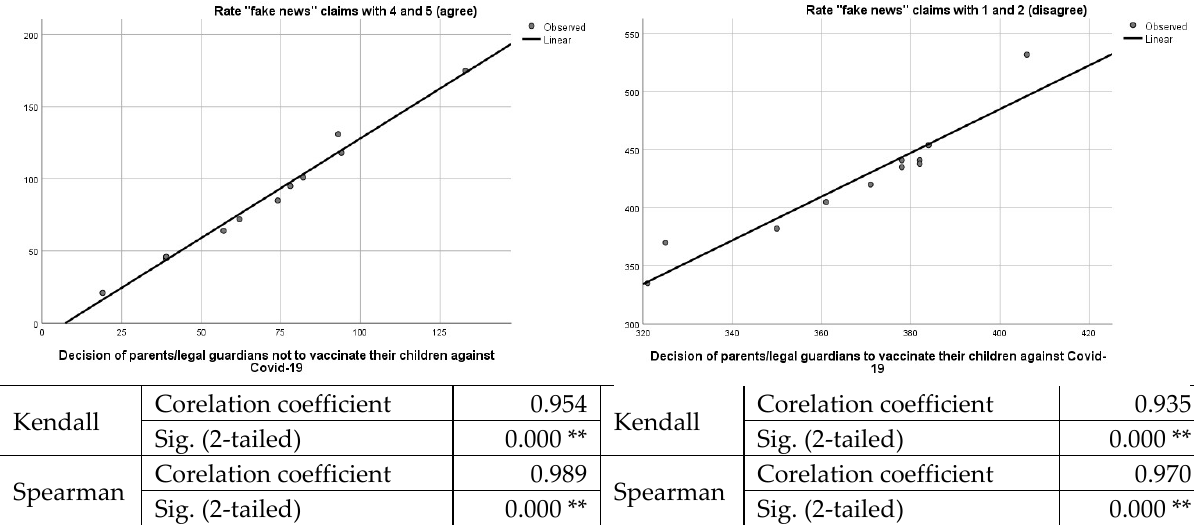
Figure 3. Graphic representation of the correlation between individuals who trust “fake news” (grading 4 and 5) and their decision to vaccinate their children. **. Correlation is significant at the 0.01 level (2-tailed).